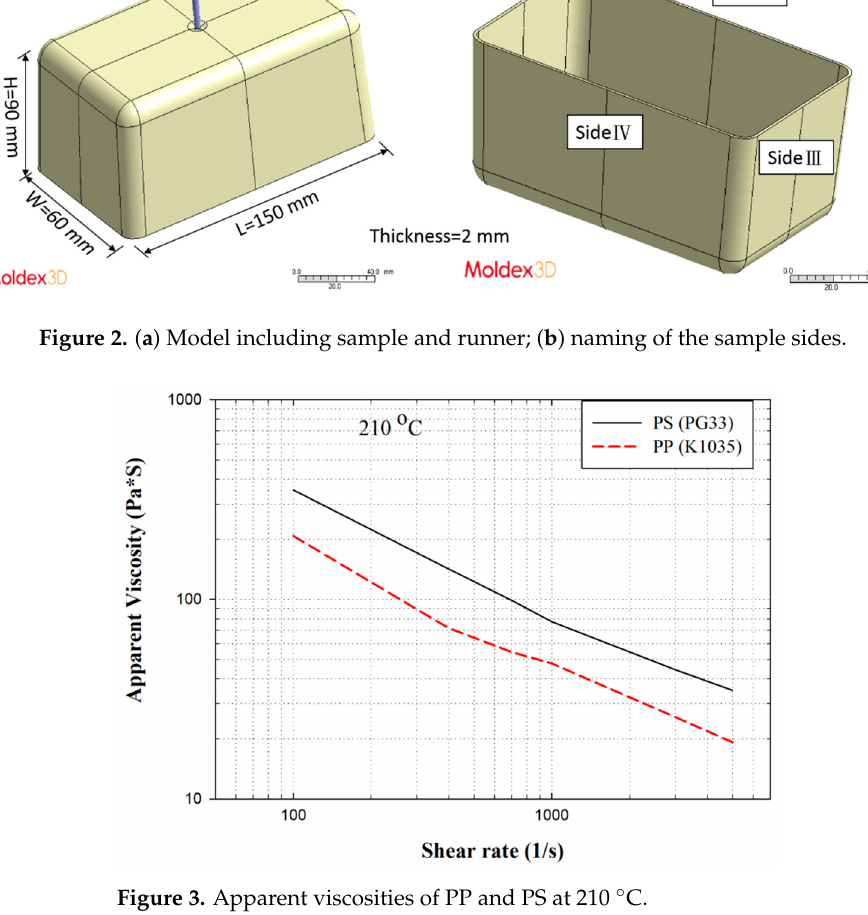
Figure 3. Apparent viscosities of PP and PS at 210 °C.